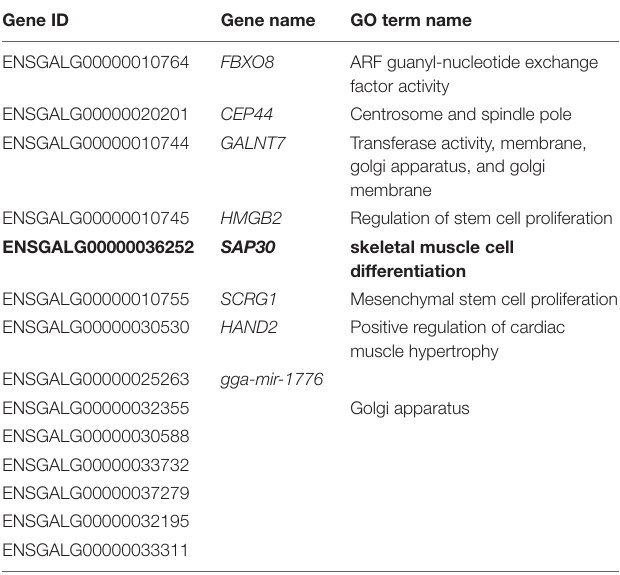
TABLE 1 | List of genes found within Quantitative Trait Loci (QTL) for breast yield in Genome-Wide Association Studies (GWAS) by Trevisoli et al. (2021) within the TT Reference Population at